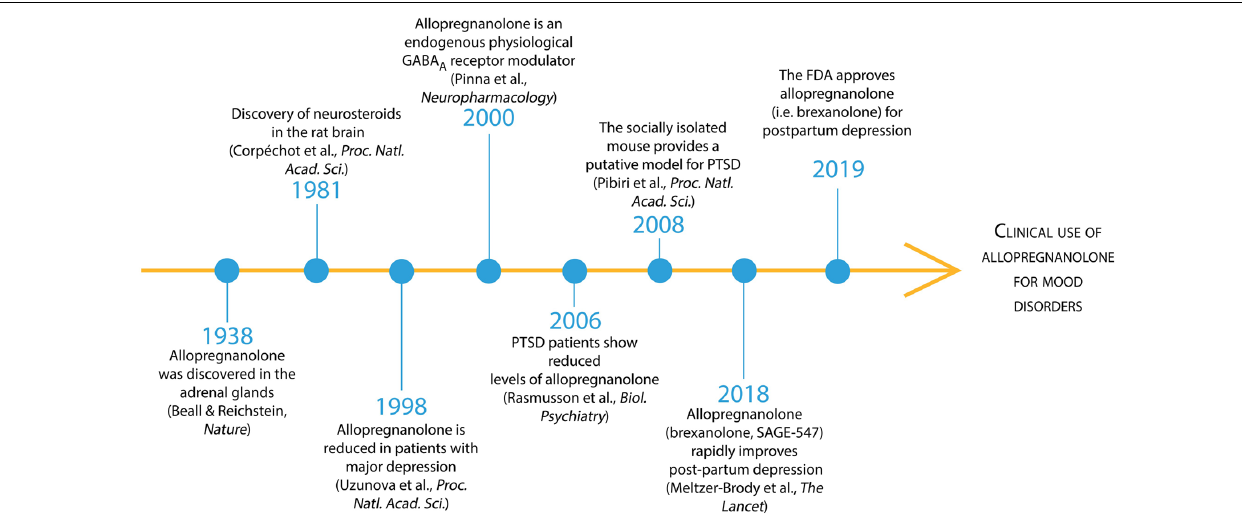
FIGURE 1 | Timeline of allopregnanolone from its discovery to FDA preapproval for the treatment of mood disorders. Beall and Reichstein discovered allopregnanolone in 1938 in the adrenal glands where 5 α -reductase metabolizes progesterone into 5 α -dihydroprogesterone and then the enzyme 3 α -hydroxysteroid dehydrogenase produces allopregnanolone (Beall and Reichstein, 1938). In 1981, Baulieu’s team discovered that the brain “acting like a peripheral gland” synthetize allopregnanolone de novo starting from pregnenolone, the precursor of all neurosteroids (Corpéchot et al., 1981). Allopregnanolone’s pharmacological effects following its administration in animal models and humans are mediated by the fast allosteric modulation of the action of GABA at GABA A receptors (Majewska et al., 1986; reviewed in Belelli et al., 2009). The neurophysiological role of allopregnanolone in fine-tuning GABA A receptors to agonists, positive allosteric modulators, and GABAmimetic agents, was unveiled thereafter (Pinna et al., 2000). Allopregnanolone levels were found decreased in mood disorders, including major unipolar depression and PTSD (Romeo et al., 1998; Uzunova et al., 1998; Rasmusson et al., 2006, 2019). An animal model of stress-induced behavioral dysfunction, including fear extinction deficits and aggressive behavior associated with a corticolimbic allopregnanolone biosynthesis downregulation was proposed therein after (Pinna et al., 2008; Pibiri et al., 2008). More recently, phase 3 clinical trials have established the clinical relevance of allopregnanolone in mood disorders (Kanes S. J. et al., 2017; Meltzer-Brody et al., 2018). Intravenous allopregnanolone (brexanolone or SAGE-547) or an orally-active, allopregnanolone’s analog (SAGE-217), showed a rapid and long-lasting remission of post-partum depression and major depressive disorder symptoms, respectively. These successful clinical trials led to the FDA approval of brexanolone for the treatment of post-partum depression in March 2019 and encouraged the possible future clinical use of brexanolone or SAGE-217 for the treatment of mood disorders, including